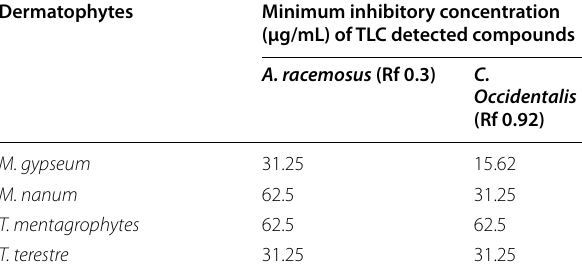
Table 3 Minimum inhibitory concentration of TLC detected bioactive compounds from A. racemosus and C. occidentalis against dermatophytes Dermatophytes Minimum inhibitory concentration (µg/mL) of TLC detected